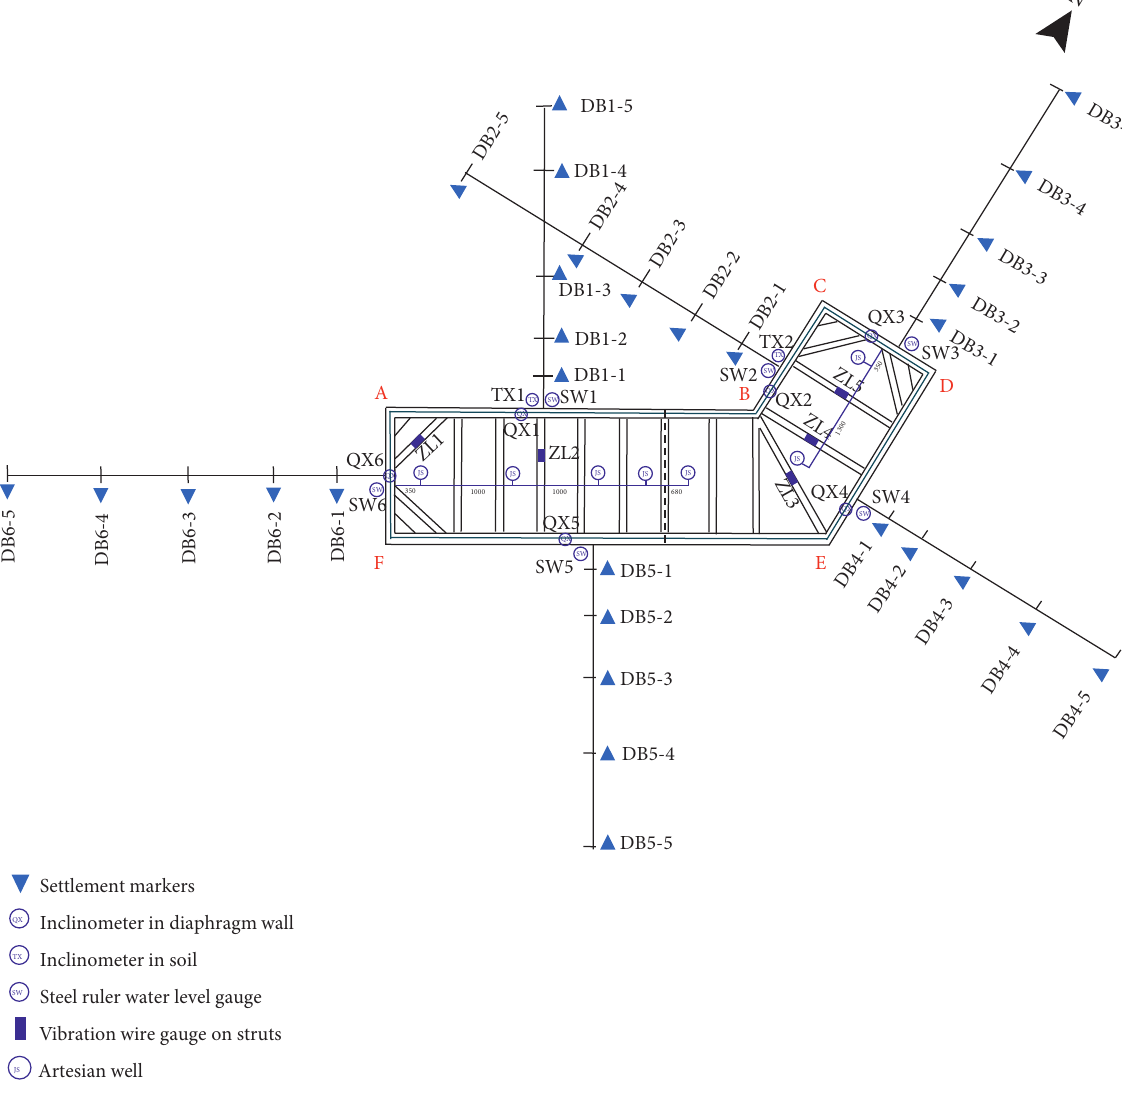
Figure 6: Monitoring layout of the foundation